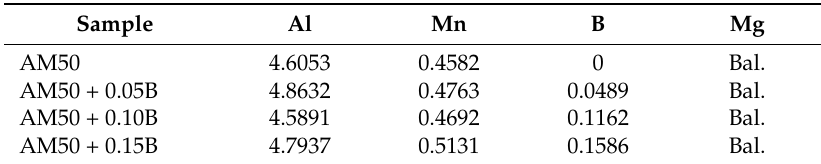
Table 1. Actual chemical compositions (wt. %) of the AM50 + xB (x = 0, 0.05, 0.1, 0.15 wt.%) alloys. Sample